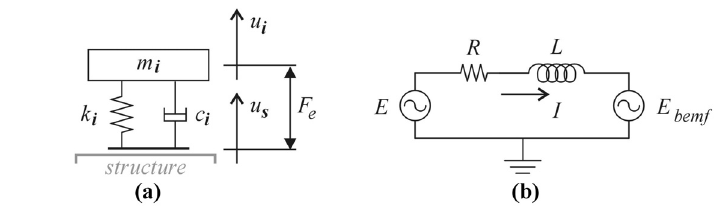
Fig. 6. Electro-mechanical model of an inertial shaker: (a) mechanical and (b) electrical